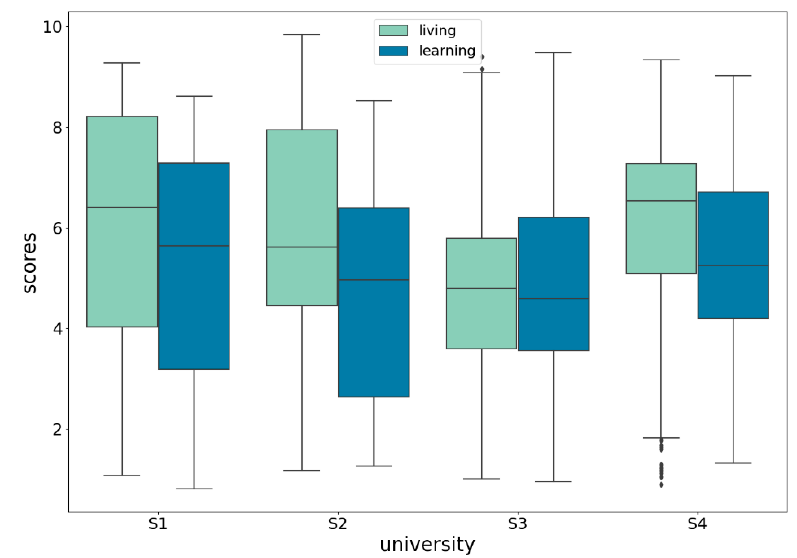
Figure 2. Box plot of data from 4 universities.